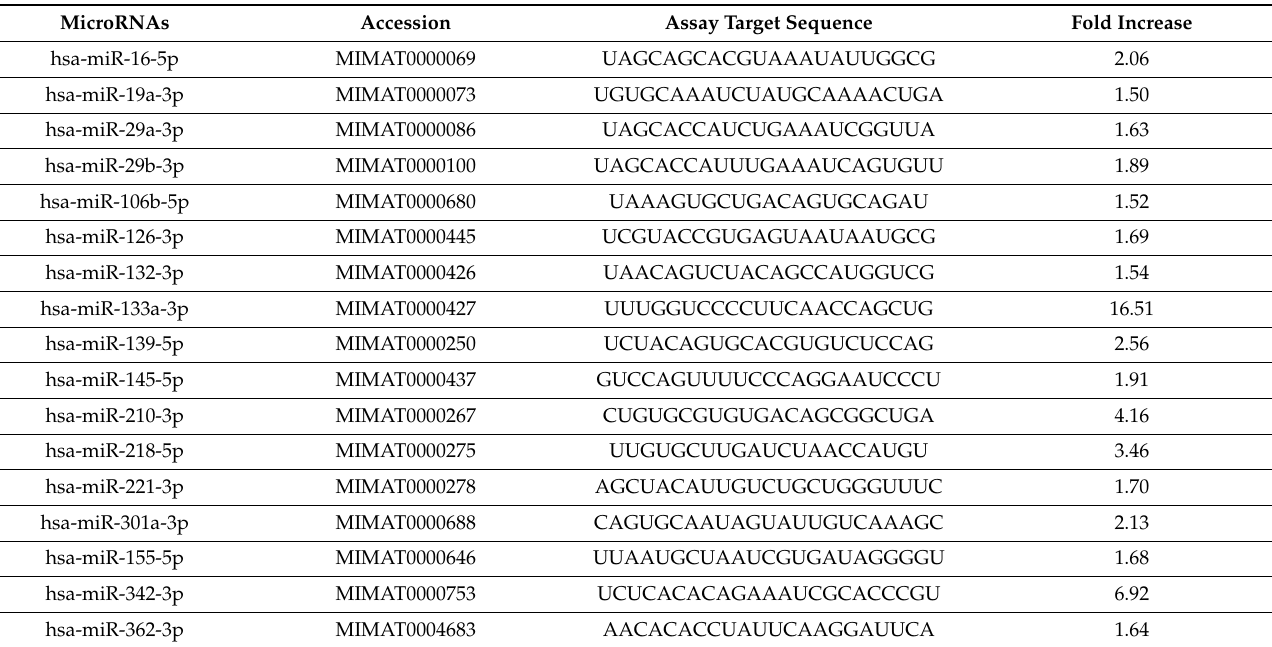
Figure 2. Dot plot of the 23 dysregulated MAC miRNAs. Twenty-one miRNAs were found to be upregulated and two downregulated by the microarray analysis after systematic exclusion. Table 2. Dysregulated miRNAs identified by the microarray analysis. Table includes the miRNA accession code (miRBase Identification Code), microarray assay target sequence, and fold